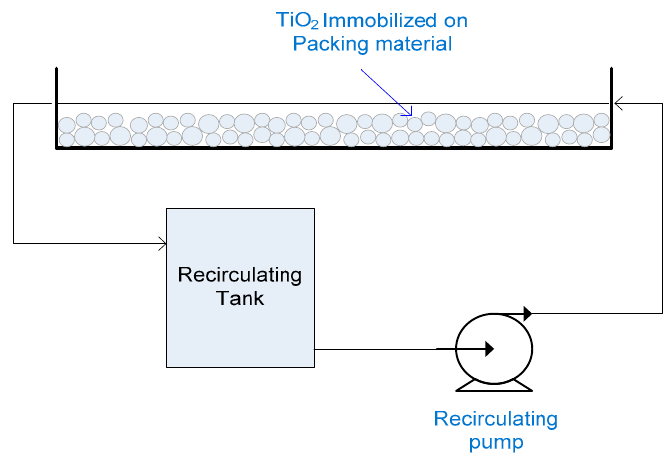
Figure 9. Schematic drawing of packed bed reactor system.